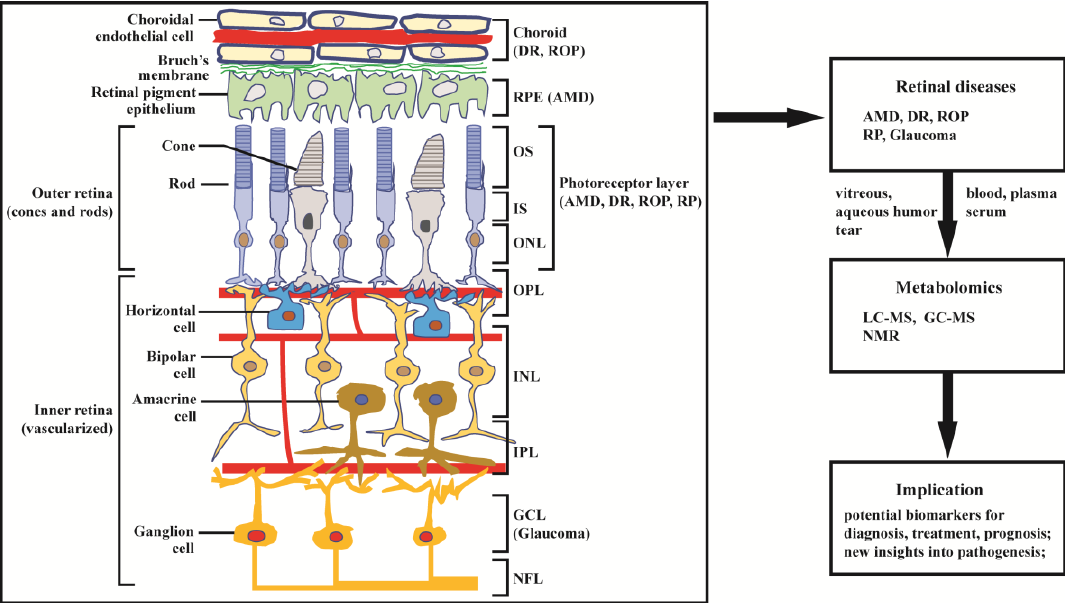
Figure 1. Structure of retina and application of metabolomics to retinal diseases. The retina can be divided into inner retina and outer retina. The inner retina consists of the nerve fiber layer (NFL) ganglion cell layer (GCL), inner plexiform layer (IPL), inner nuclear layer (INL, where amacrine, bipolar, and horizontal cells are localized), and outer plexiform layer (OPL); the outer retina consists of the outer nuclear layer (ONL) of rod and cone photoreceptors, which are compartmentalized as outer segments (OS) and inner segments (IS). The retinal pigment epithelium (RPE) cells and choroid endothelial cells provide nutrition across Bruch’s membrane to support photoreceptor cells. Age-related macular degeneration (AMD) primarily affects the RPE and photoreceptor cells; diabetic retinopathy (DR) and retinopathy of prematurity (ROP) mainly affects choroidal vasculature and the photoreceptors; retinitis pigmentosa (RP) and glaucoma predominantly affect, respectively, the photoreceptors and ganglion cells. Damage in retinal structure can lead to retinal diseases, including AMD, DR, ROP, glaucoma, and RP. The diseases have been extensively studied by metabolomics based on LC-MS, GC-MS, and